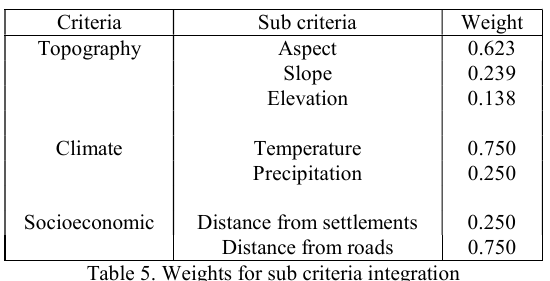
Table 5. Weights for sub criteria integration